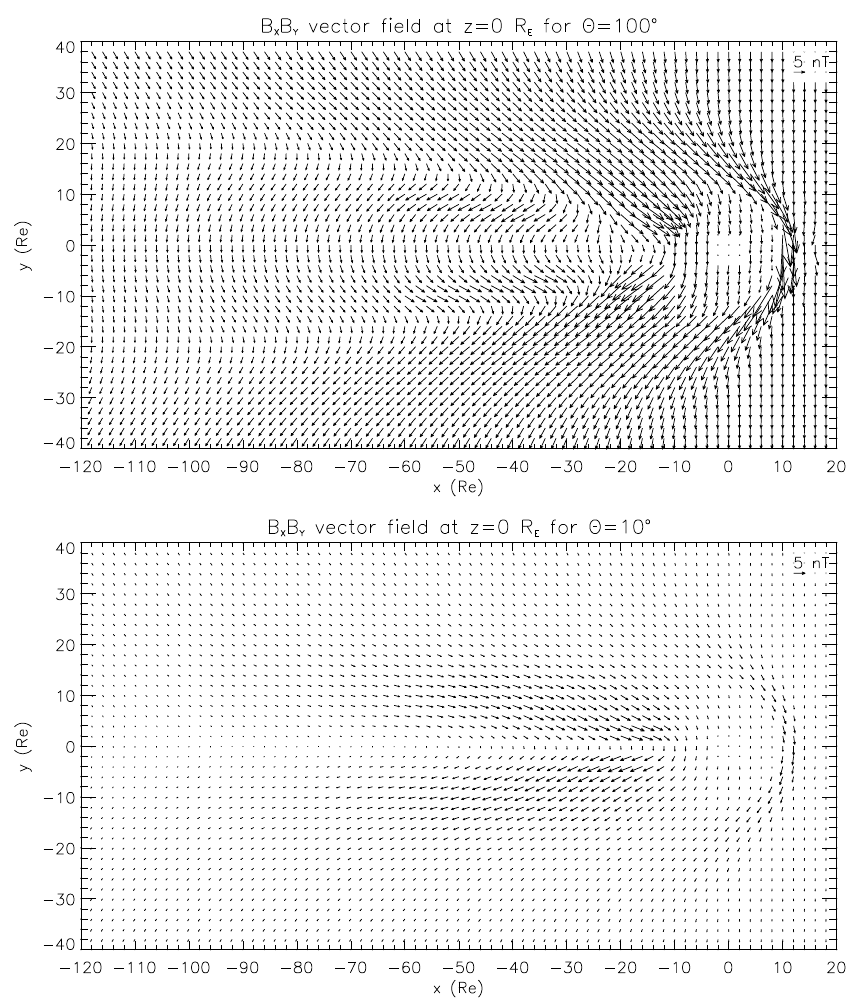
Fig. 4. The magnetic field in the equatorial plane for two constant IMF runs 1a (up) and 1d (down). The vectors are plotted every 2 R E down to a distance of 4 R E from the Earth is